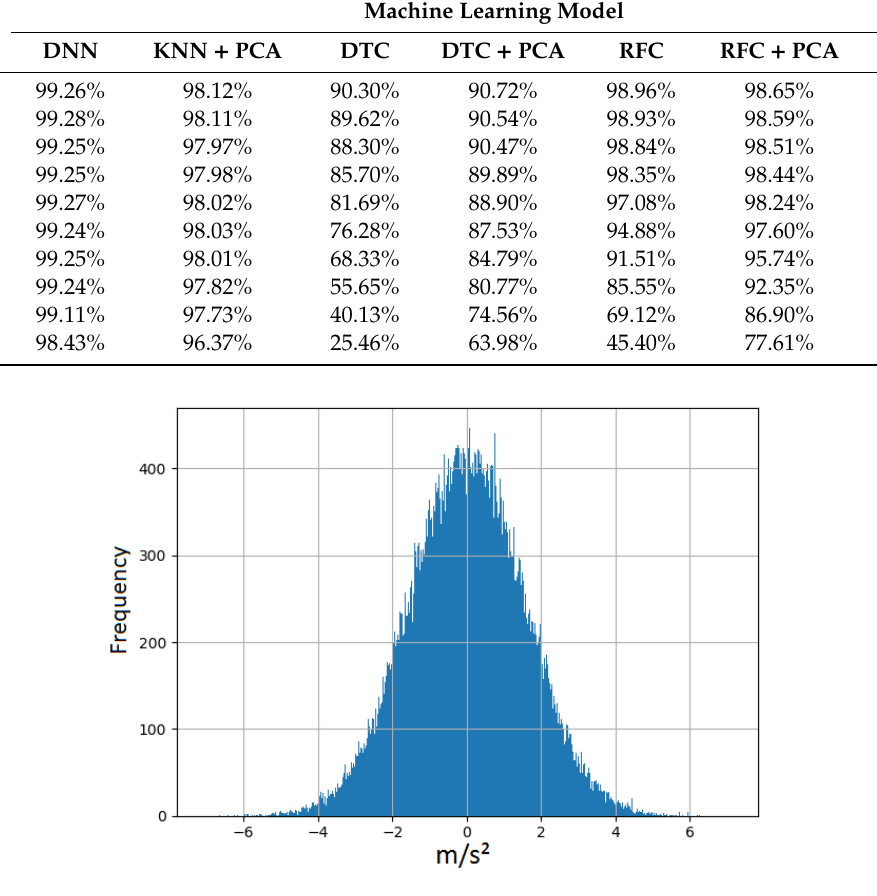
Figure 2. A histogram for a thermal noise sample added to one accelerometer axis in all test instances.